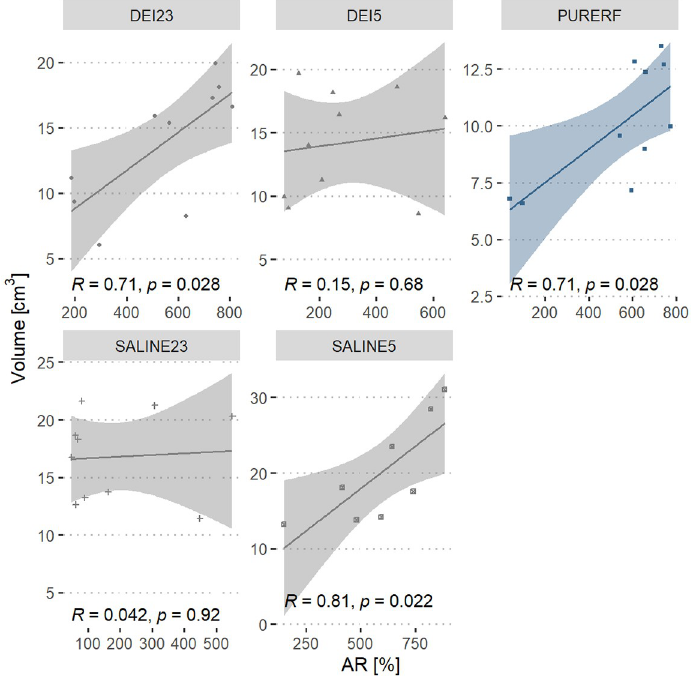
Fig 10. Correlation between AR performance index and volume. The graph presents the correlation between the volume in the groups and the AR index.